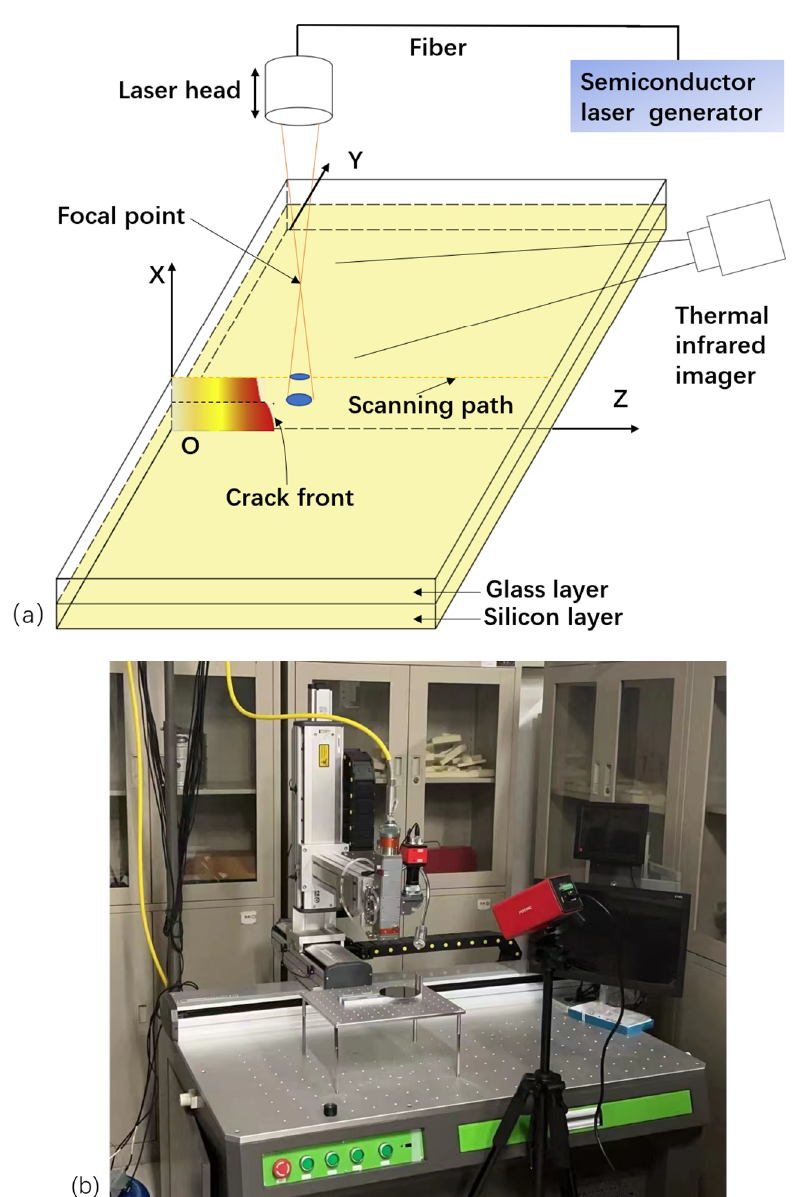
Figure 1. ( a ) Schematic of the experimental setup and the coordinate system of the specimen. ( b ) Physical image of the experimental equipment.